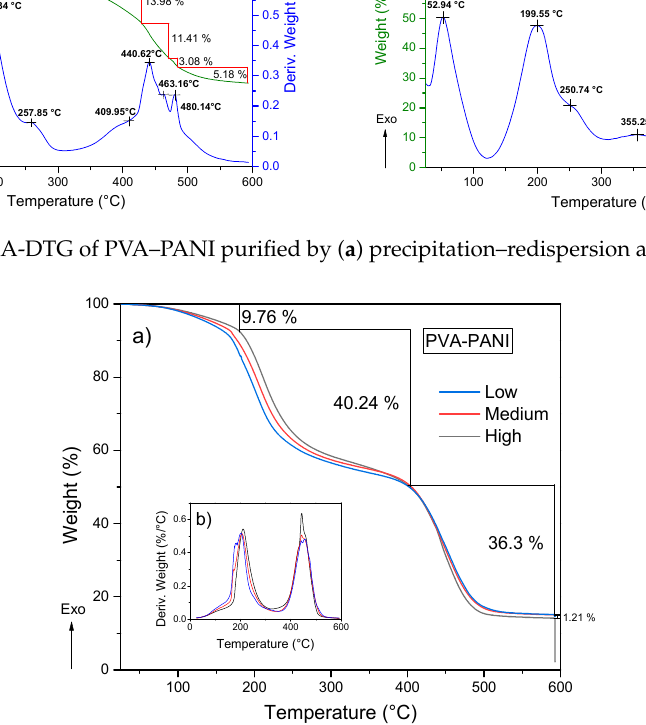
Figure 12. DSC of purified PVA–PANI gels at low, medium, and high concentrations of PANI. The obtained TGA-DTG results for PVA–PANI-G gels are shown in Figure 13. First, a weight loss of 6 to 9% can be observed, which corresponds to the loss of absorbed solvent and moisture. Subsequently there is a weight loss of 33 to 41% corresponding to the loss of pendant functional groups and hydroxyl and/or amino terminal groups. Starting at 400 °C, the degradation of the copolymer is seen, which no longer presents a gradual and constant decomposition as shown in Figure 11. At this range of temperature, the material shows two stages of weight loss, one with an almost linear loss with respect to the increase in temperature and another with gradual degradation, which can be attributed to a modification in the main chain of the polymer caused by the interaction with GA. PVA–PANI at high concentration activated for 30 min showed the best thermal properties.